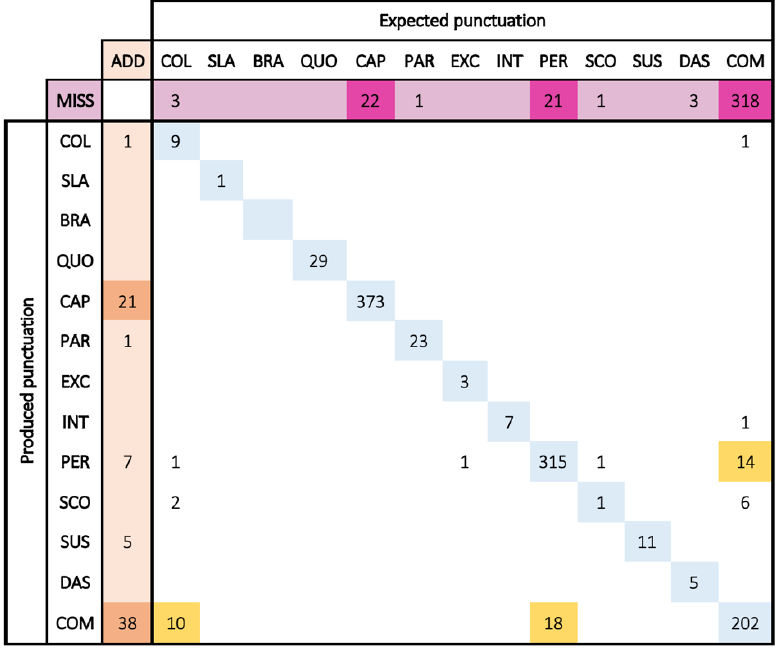
Table 4. Punctuation rate in both groups (Welch